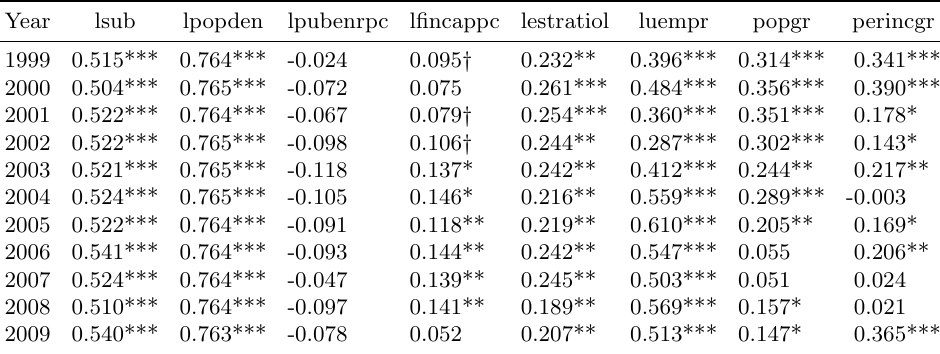
Table 3: Global Moran’s I